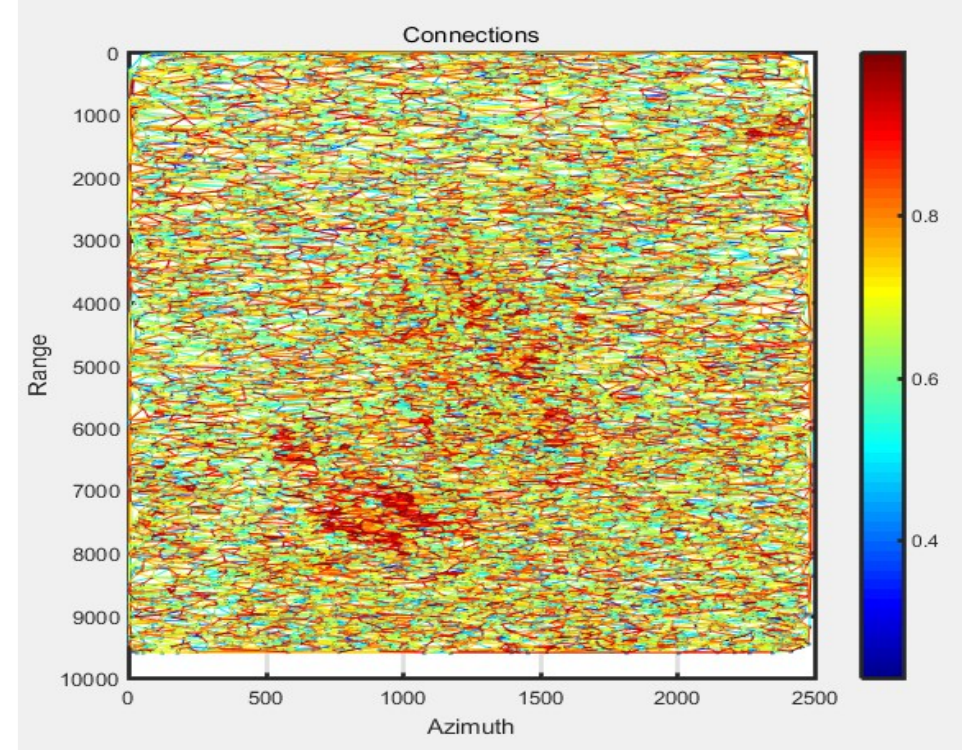
Figure 3. Coherence connection graph.